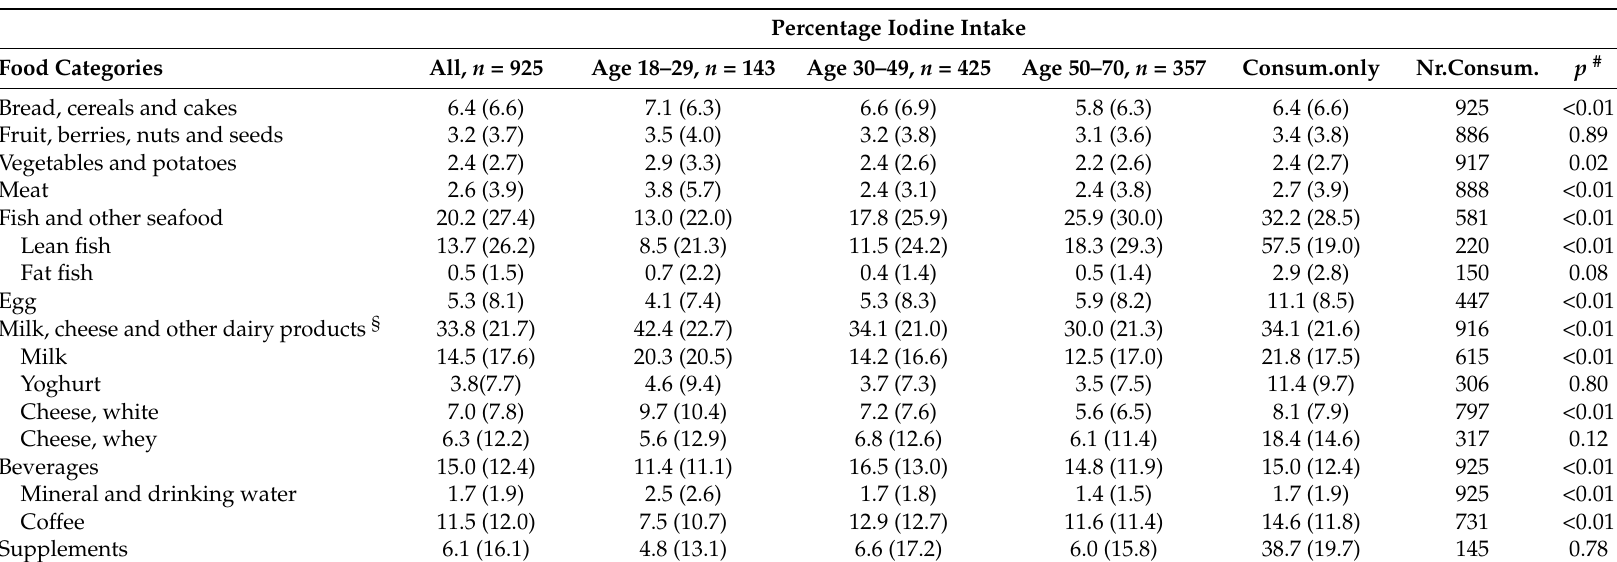
Table 4. Percentage iodine intake from different food categories, in women, different age groups and for the consumers only, mean, and